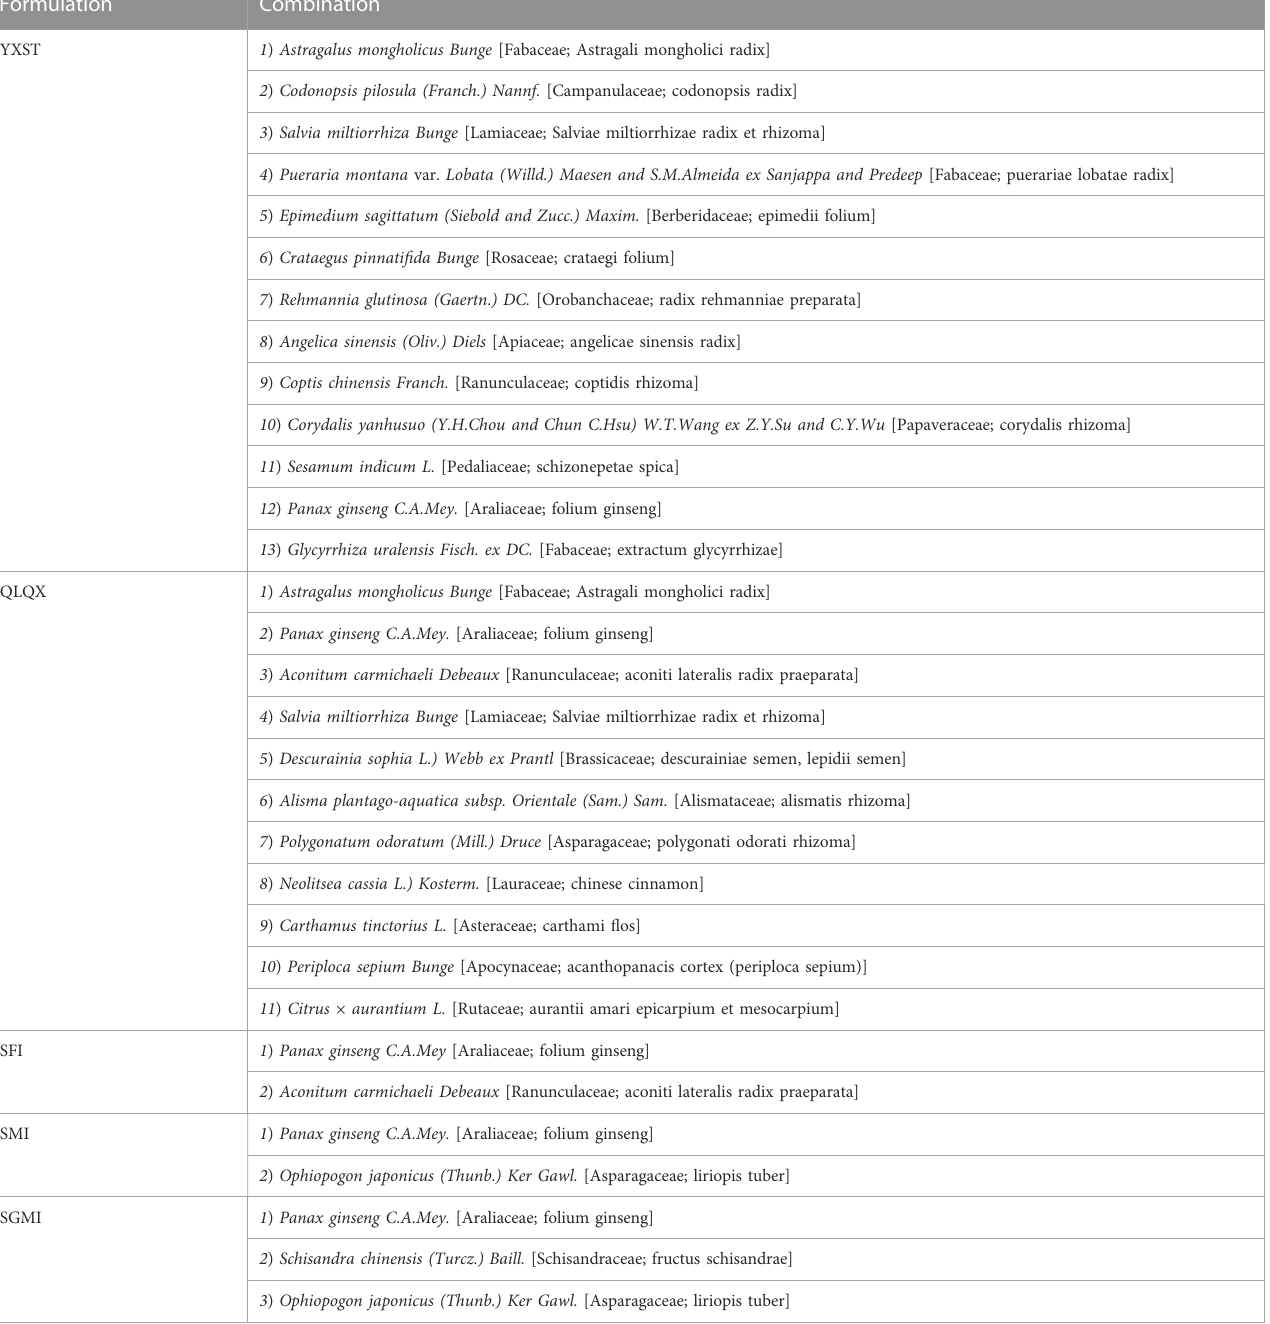
TABLE 2 Five ginseng-containing TCM included in the meta-analysis.